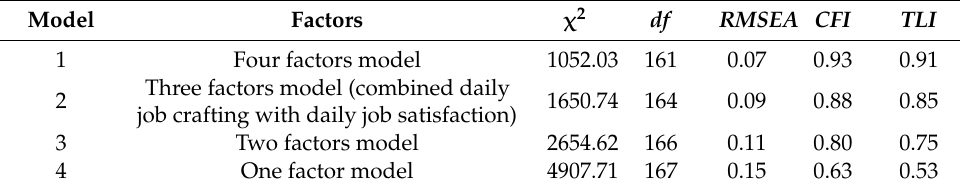
Table 1. Results of confirmatory factor analysis.